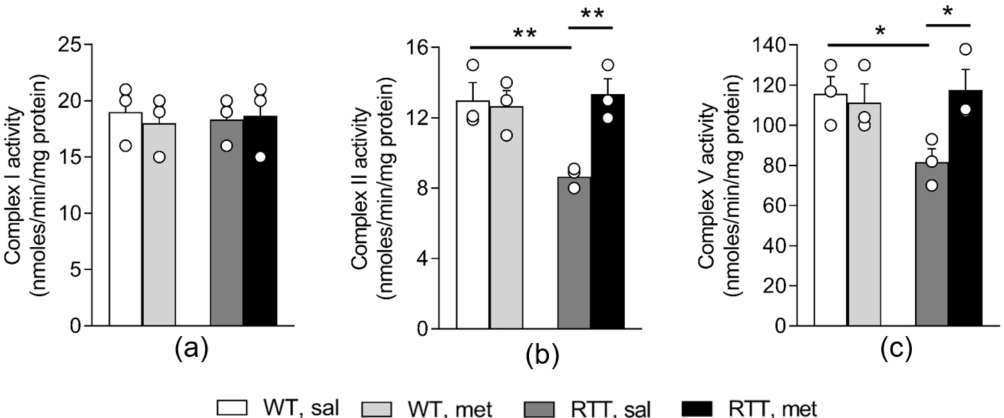
Figure 2. Metformin treatment restores mitochondrial complex II and V activity in the brain of RTT mice. The activity of complex I ( a ) did not di ff er between the two genotypes and was not a ff ected by the metformin treatment. The activity of mitochondrial respiratory chain complex II ( b ) and complex V ( c ) was reduced in RTT mouse brain compared to WT controls and metformin treatment restored WT-like levels. N = 3. Data are mean ± SEM. Statistical significance was calculated by two-way ANOVA, with Tukey’s post hoc test. * p < 0.05, ** p < 0.01. WT: wild-type mice; RTT: